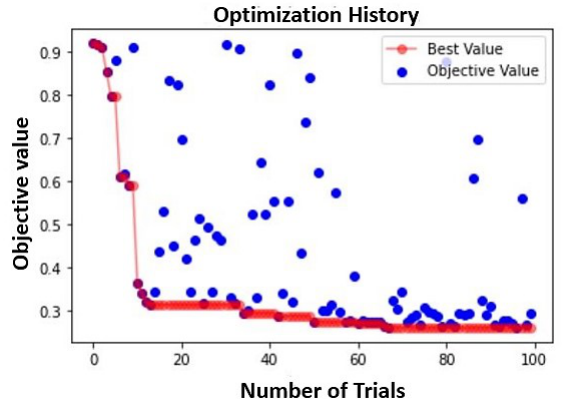
Figure 2. Optimization History Plot.